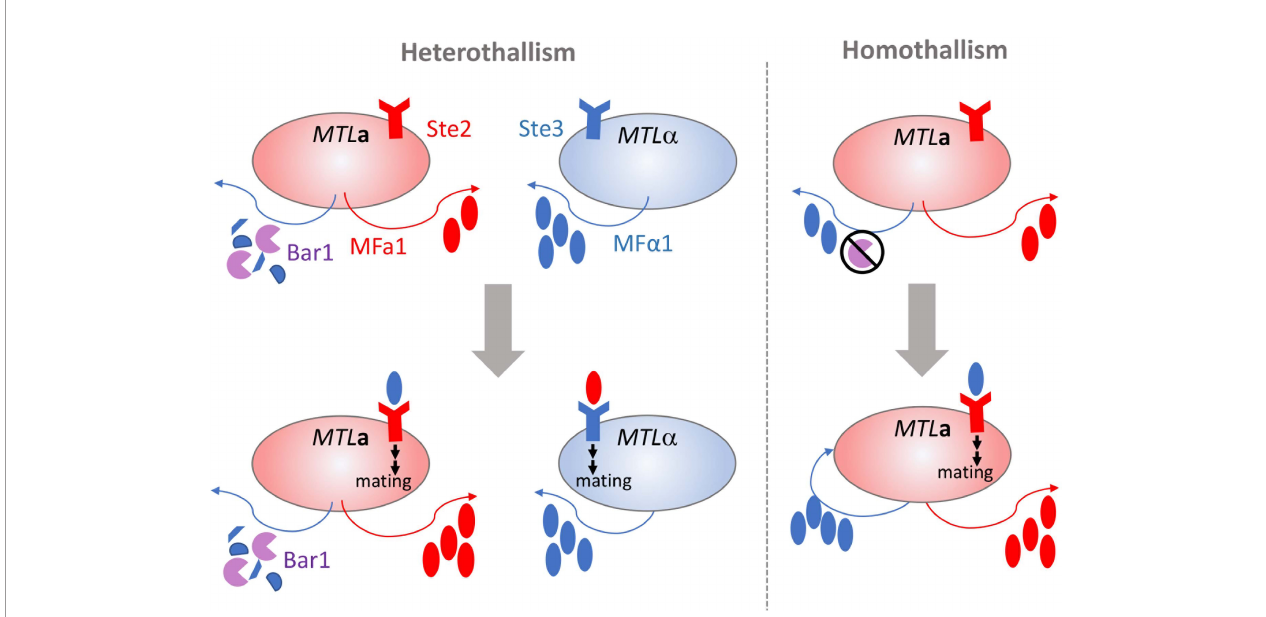
FIGURE 1 | Parasexual mating of opaque cells in C. albicans . Opaque cells of the opposite or same mating types (heterothallism and homothallism, respectively) can undergo mating and cell fusion though production and response to pheromone. In heterothallic mating (shown on left), the pheromone receptor is engaged by mating pheromone produced by cells of the opposite mating type to initiate polarized growth and cell fusion (Ste2 receptor by MF a 1 or Ste3 receptor by MFa1). Bar1 protease degrades MF a 1 produced by opaque MTL a cells and is overcome by the levels of MF a 1 produced by opaque MTL a cells. In homothallic mating (shown on right), the overproduction of MF a 1 or inactivation of Bar1 protease in MTL a leads to autocrine pheromone receptor engagement and a-a cell fusion and